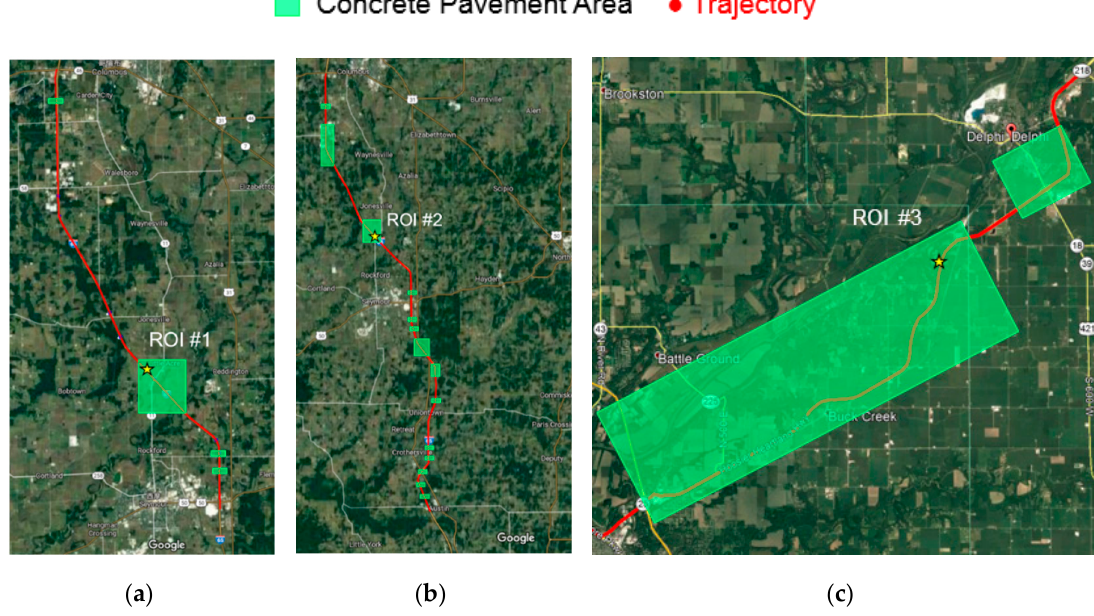
Figure 3. Location, trajectory, concrete pavement distribution, and regions of interest (ROIs) for generating intensity normalization maps of ( a ) dataset 1, ( b ) dataset 2, and ( c ) dataset